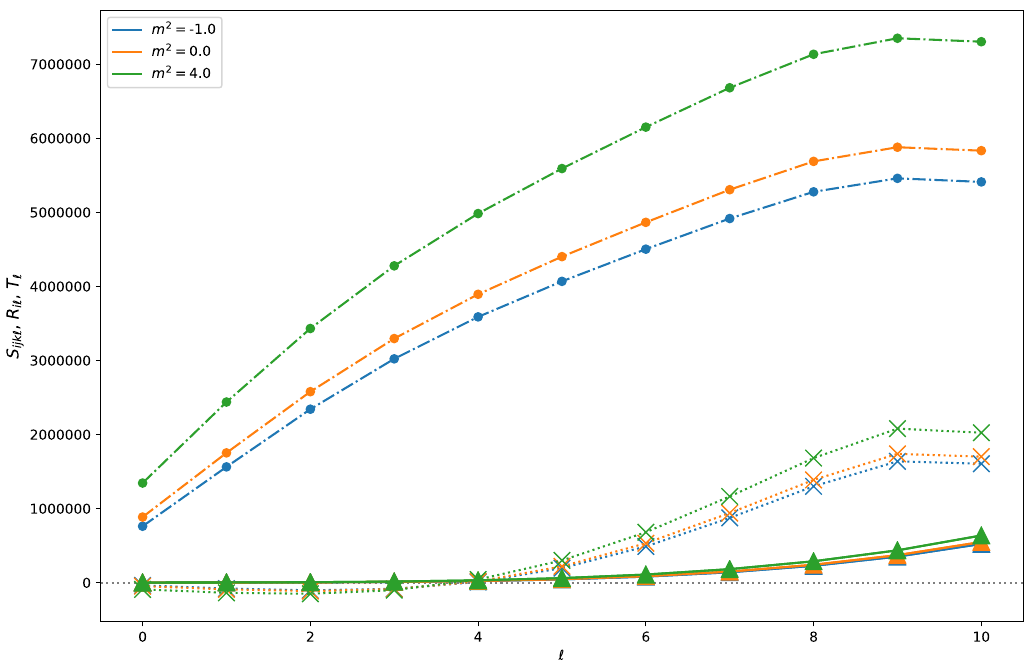
Figure 6. Evaluating (C.9)–(C.11) over different values of m 2 for ‘ ≤ 10 . S by filled circles connected by dash-dotted lines; R i‘ is denoted by filled triangles connected by solid lines; T ‘ is denoted by large Xs connected by dotted lines. Different values of m 2 are denoted by the colour of each